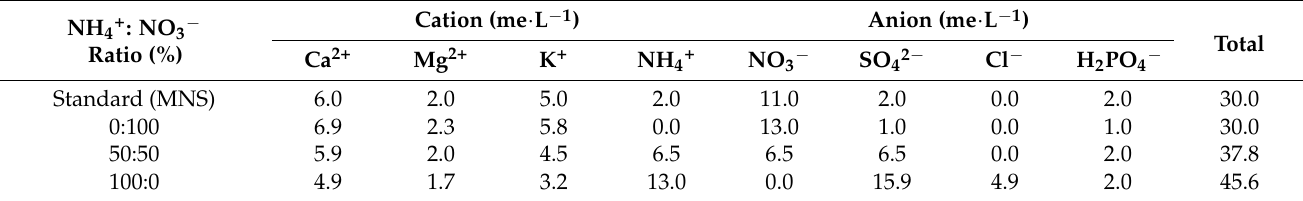
Table 1. Ion composition (me · L − 1 ) at a constant N concentration (13.0 me · L − 1 ), with three A–N ratios used as the treatment